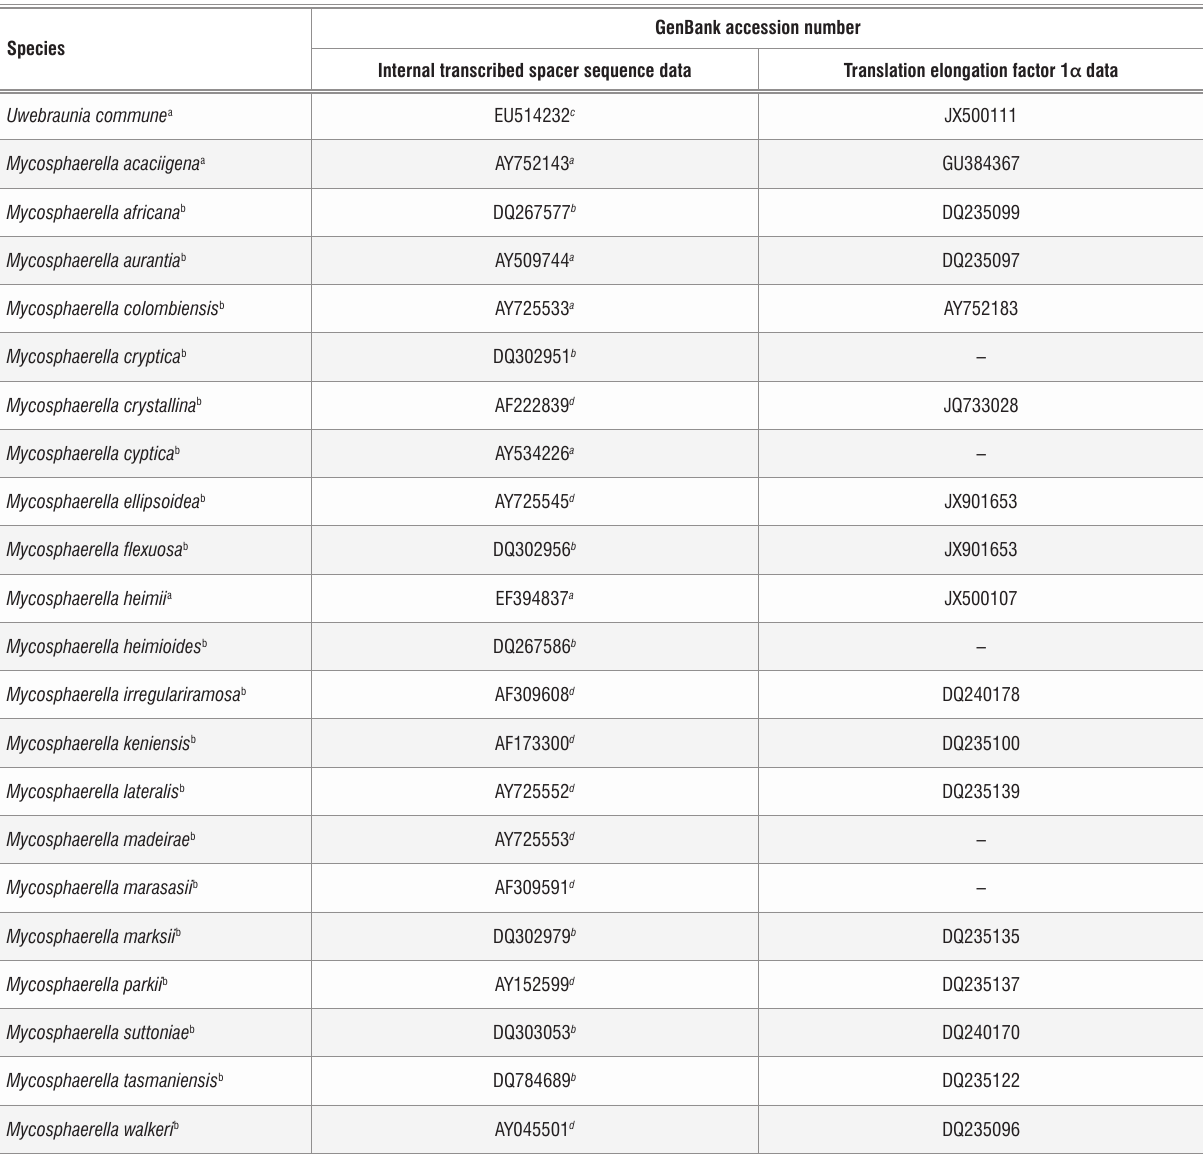
GenBank accession number